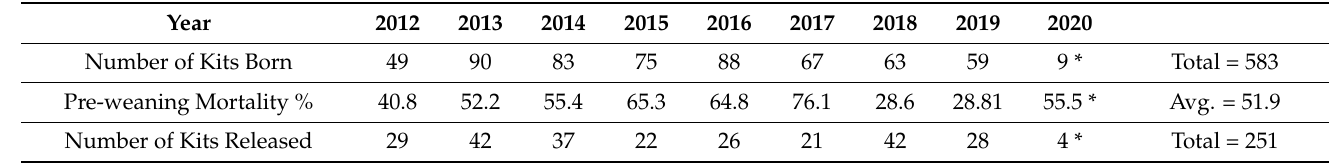
Table 1. Total number of NEC kits born at Roger Williams Park Zoo (RWPZ) since 2012, pre-weaning mortality percentage, and number of kits